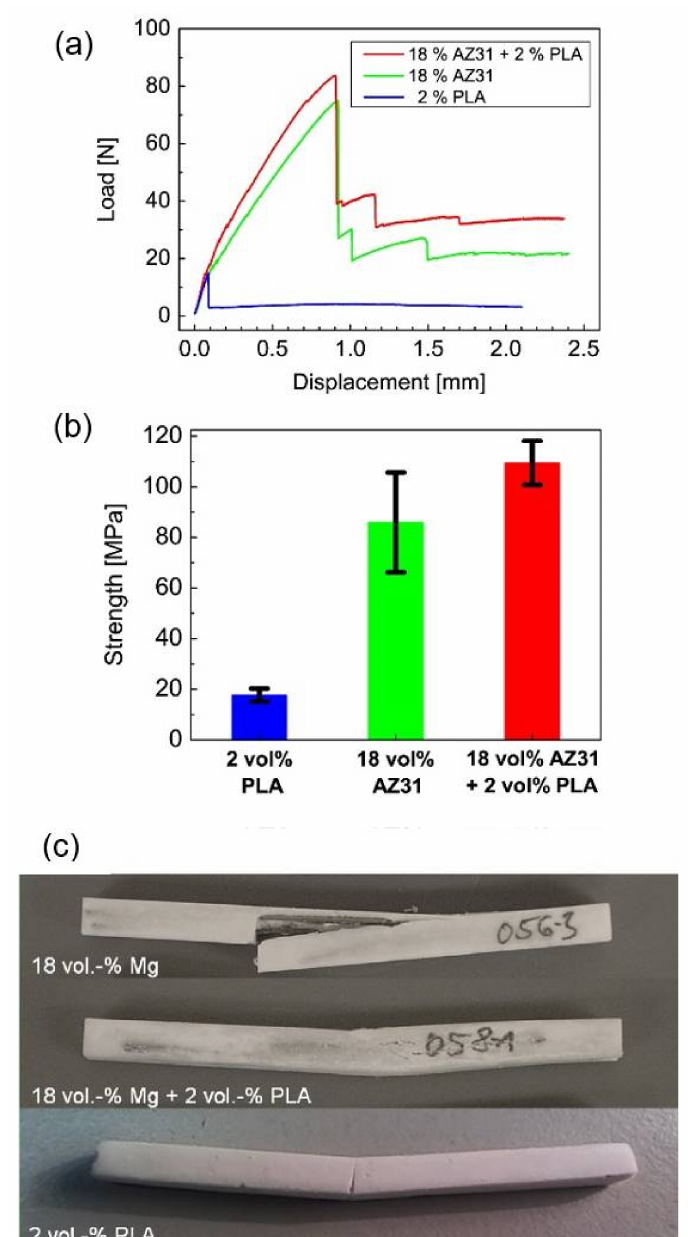
Figure 10. Comparison between three different compositions of FRCPC including AZ31, PLA and hybrid (both AZ31 and PLA). ( a ) Load-displacement curves; ( b ) Bending strength and ( c ) Fracture images of the composites, reproduced with permission from [114], Elsevier,